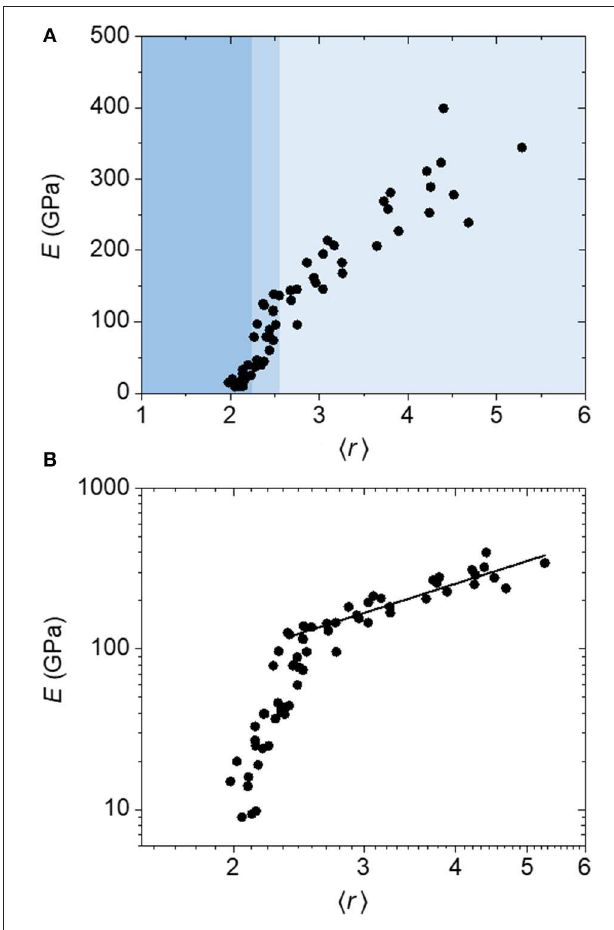
FIGURE 5 | (A) Linear and (B) log plots of Young’s modulus ( E ) as a function of average coordination number ( h r i ) calculated using a “superatom” constraint counting method for a-BC:H films. The data above the transition region is fit to a power-law function to yield an exponent of 1.5.